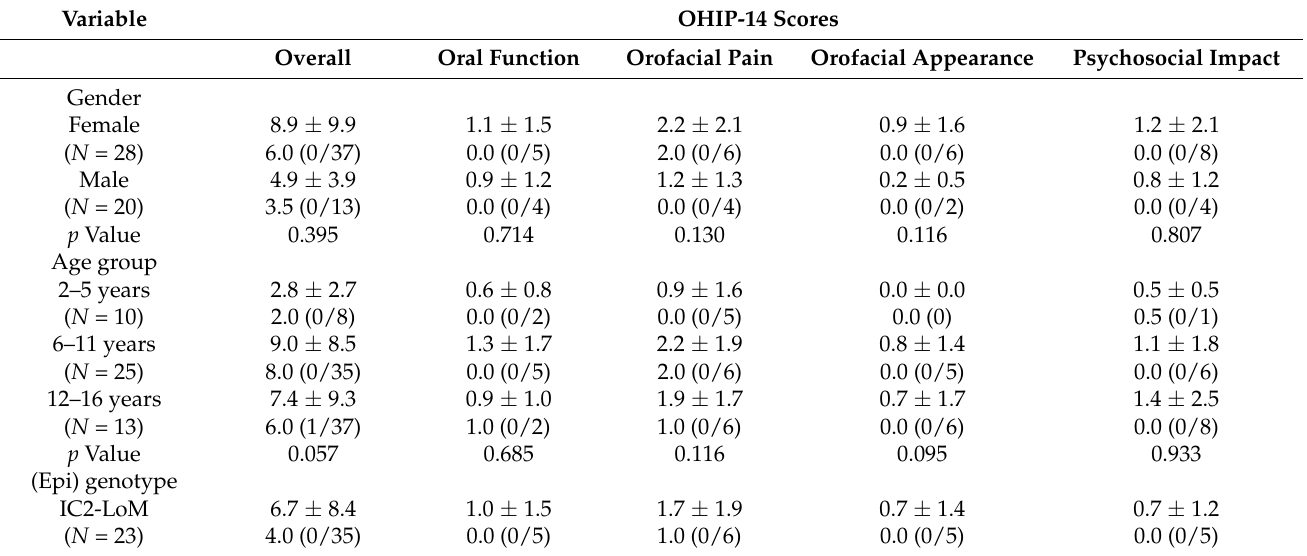
Table 2. Overall and subscale OHIP-14 scores in BWS patients by gender, age, genotype and tongue reduction surgery (mean ± SD, median,